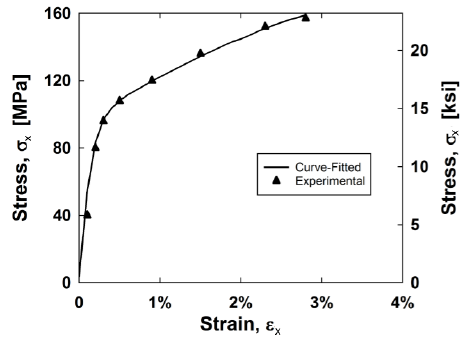
Figure 8. Experimental and curve-fitted shear stress – shear strain relationships.